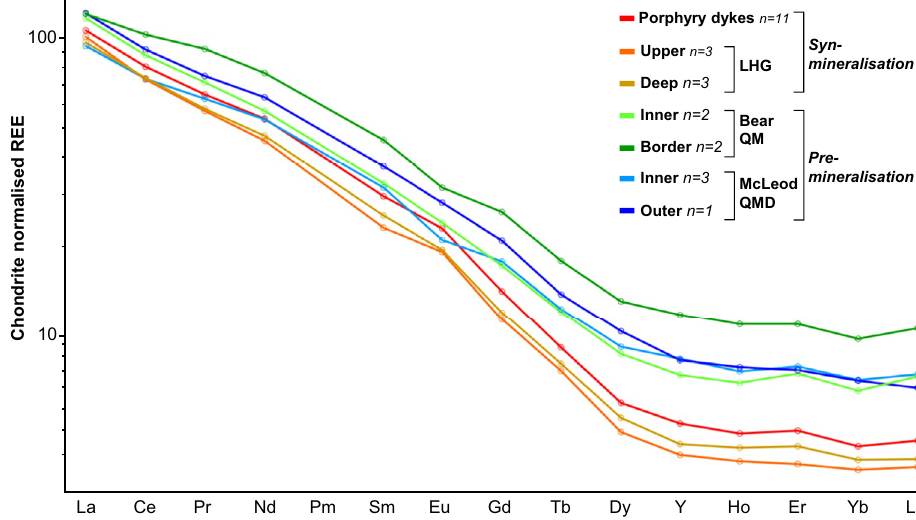
Figure 5. Chondrite-normalised 111 mean whole-rock REE plots. LHG and porphyry dykes are distinct from the Bear QM and McLeod QMD intrusions, having slightly positive Eu anomalies and steeper MREE/HREE curves. All data plotted in Fig.